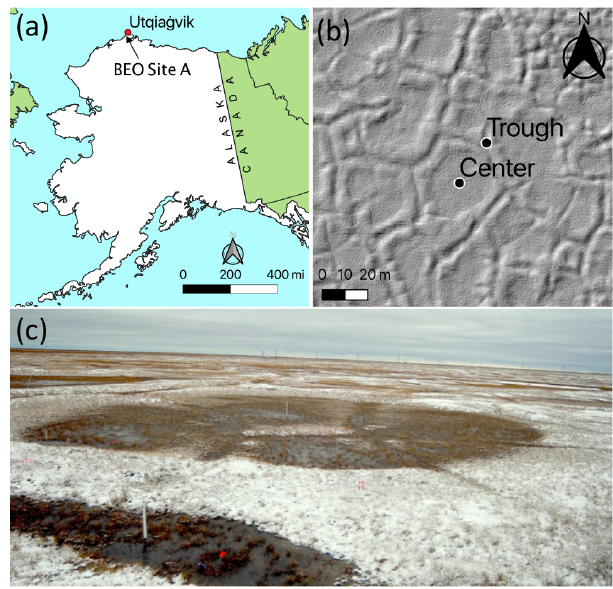
Figure 2. (a) Map; (b) hillshade relief with well locations; and (c) photo of the Barrow Environmental Observatory (BEO) Site A near Utqia˙gvik, Alaska. Photo courtesy of Bob